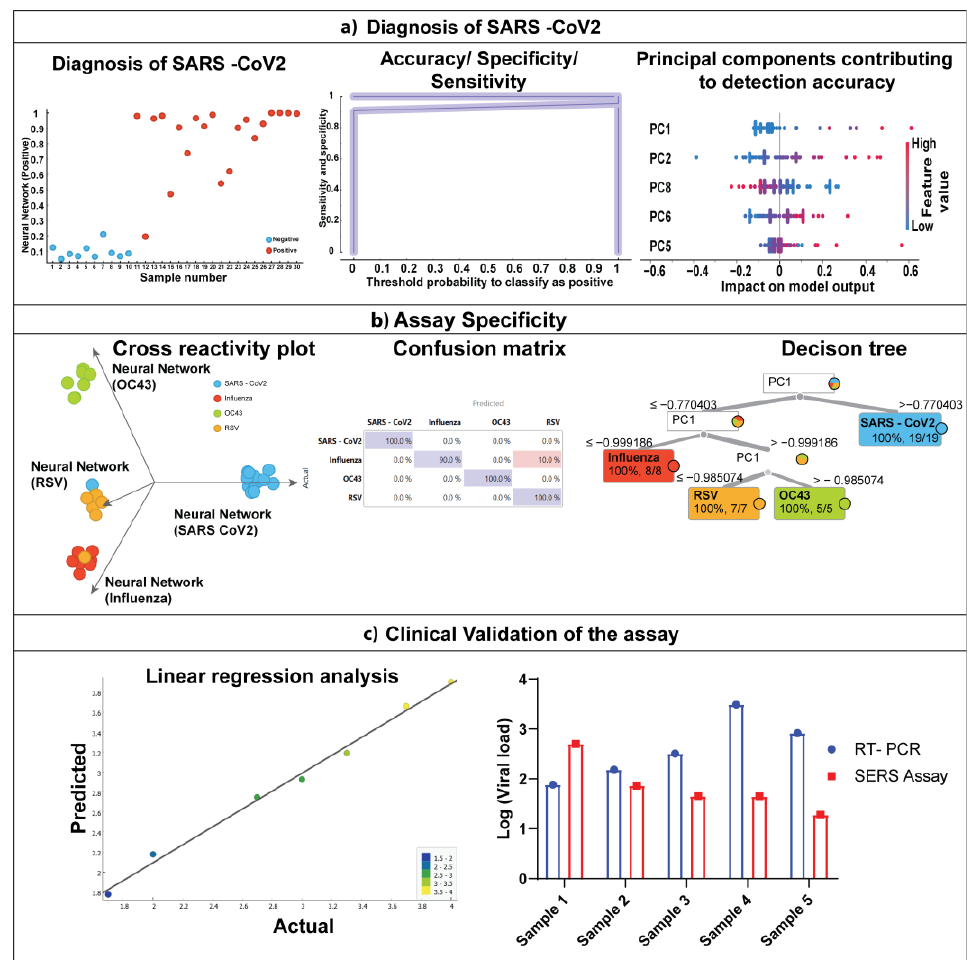
Figure 6. Direct diagnosis of SARS-CoV-2 virus from saliva samples ( a ) diagnostic parameters of covid detection using Nanosensors ( b ) Applicability of nanostructured sensor for differentiating similar viruses ( c ) Clinical validation of the assay with RT-PCR.